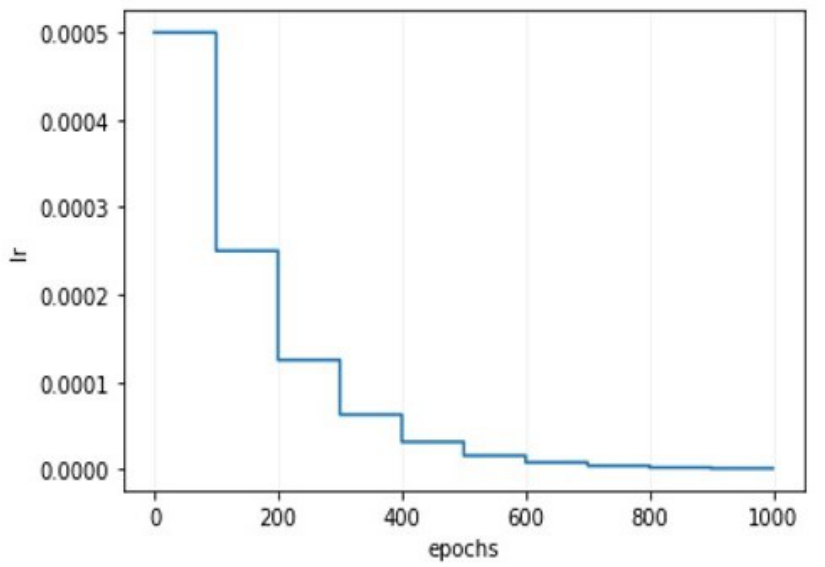
Figure 12. Learning rate with decay rate 0.5.